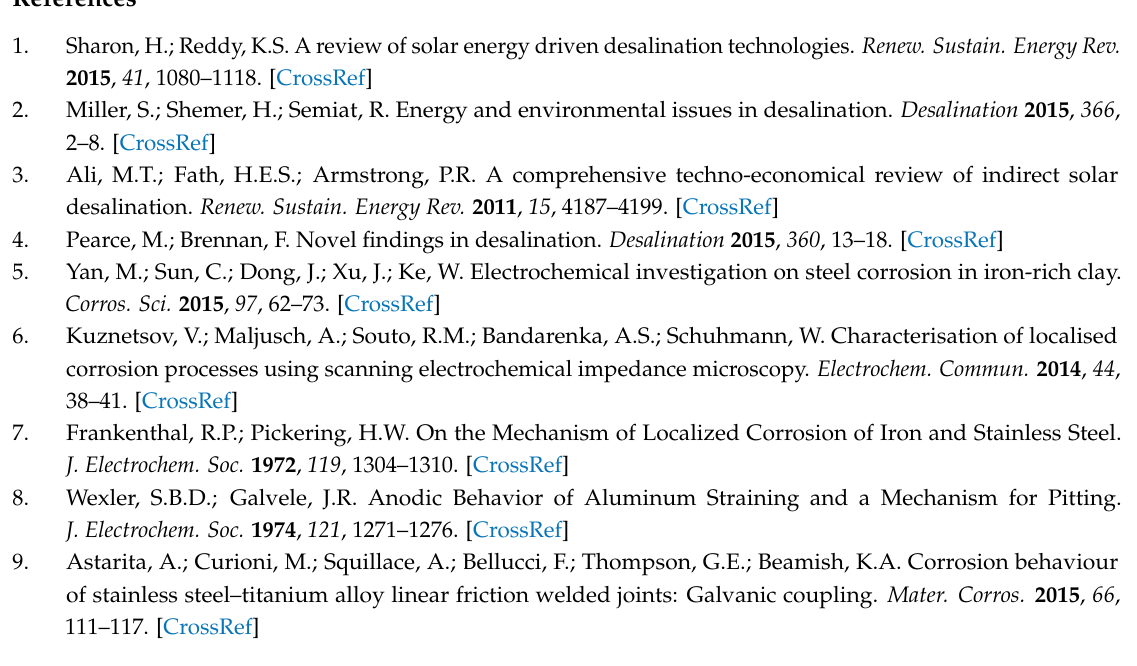
Figure S1: Open circuit potential OCP (vs. saturated calomel electrode (SCE)/V) distribution maps of the CMEA1 (HAl77-2/316L SS/TA2) after immersion in artificial seawater with 2.7% chloride ions (wt.%); Figure S2: Spatial potential (left, V/SCE) and corresponding current (right, I/A) distribution maps of CMEA1 after being short-circuited for 12 h in artificial seawater with 2.7% chloride ions (wt.%); Figure S3. OCP (vs. SCE/V) distribution maps of CMEA2 after immersion in artificial seawater with 2.7% chloride ions (wt.%); Figure S4. Spatial potential (left, V/SCE) and corresponding current (right, I/A) distribution maps of CMEA2 after being short-circuited for 12 h in artificial seawater with 2.7% chloride ions; Figure S5. Potential distribution maps of CMEA3 at OCP (V/SCE) after immersion in artificial seawater with 2.7% chloride ions (wt.%); Figure S6. Spatial potential (left, V/SCE) and corresponding current (right, I/A) distribution maps of CMEA3 after being short-circuited for 12 h in artificial seawater with 2.7% chloride ions